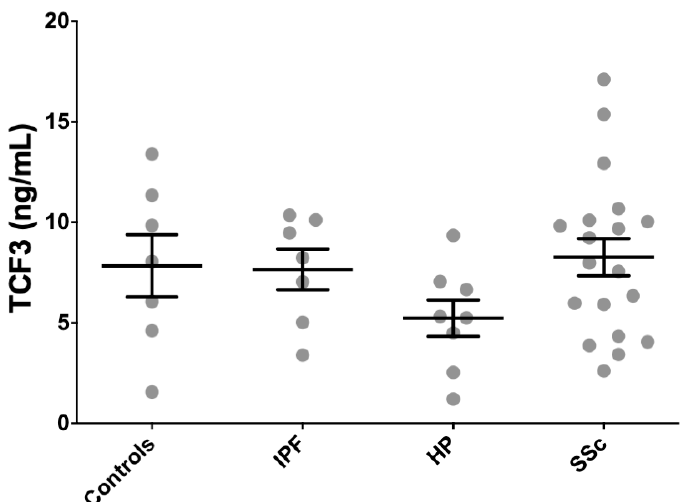
Figure 7. TCF3 serum levels did not associate with fibrotic illness. TCF3 serum levels in all patients and healthy subjects were similarly high.